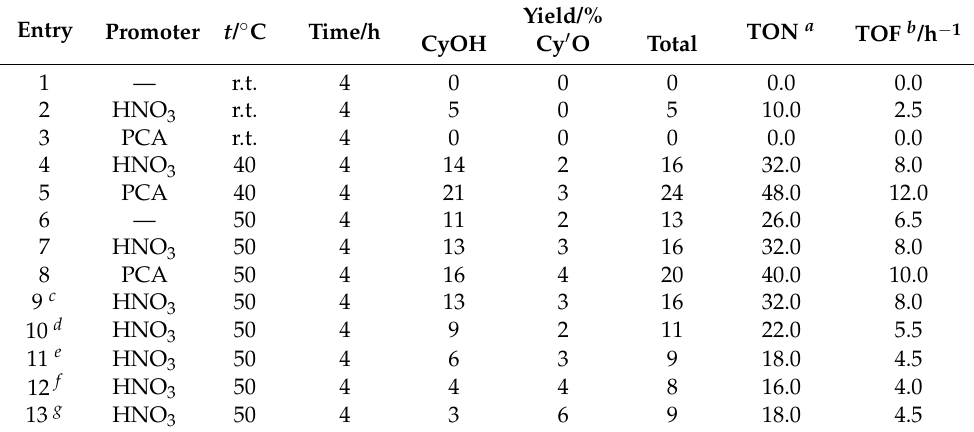
Table 2. Peroxidative oxidation of cyclohexane catalyzed by the tetranuclear Cu(II) complex 2